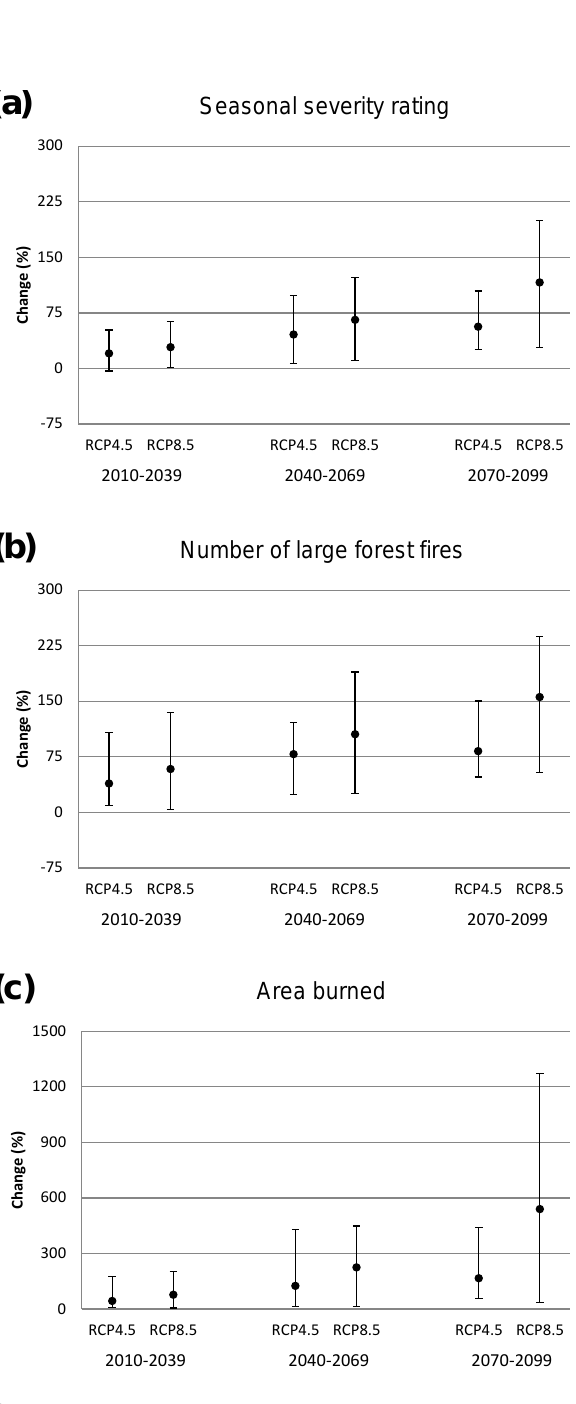
Figure 8. Projected changes in April–October seasonal severity rat- ing averaged over the whole of Finland (a) , in the number of large forest fires in Finland (b) , and in the area burned (c) compared to the period 1980–2009. Dots indicate the multi-model mean change and whiskers extend to the maximum and minimum